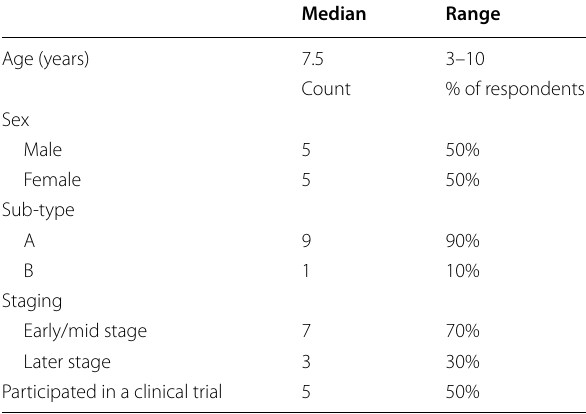
Table 3 Characteristics of child with Sanfilippo syndrome: